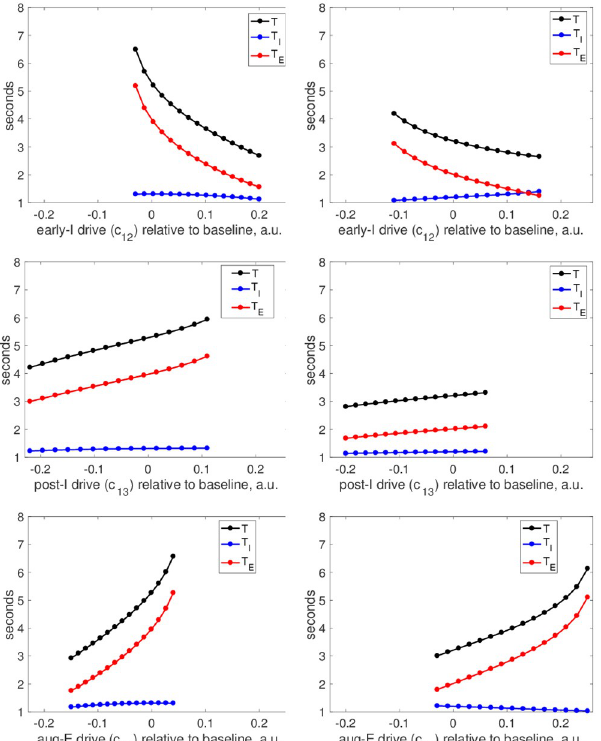
Fig 9. Inputs to different nodes in the network provide distinct period control mechanisms. Left column: pre-I is tuned to be intrinsically oscillatory ( c 11 = − 0.03). Right column: pre-I is tuned to be intrinsically tonic ( c 11 = 0.01). All panels show period (black curve), inspiratory duration (blue curve), and expiratory duration (red curve) versus the value of a drive parameter relative to its baseline value (here labeled as 0) that was varied over the full range that preserved network rhythmicity. Drive parameters used are drive to early-I, c 12 (top), drive to post-I, c 13 (middle), and drive to aug-E, c 14 (bottom). Drive parameters are fixed at c 12 = 0.19, c 13 = 0.58, c 14 = 0.2 unless being varied. The same horizontal and vertical axis ranges are used in all